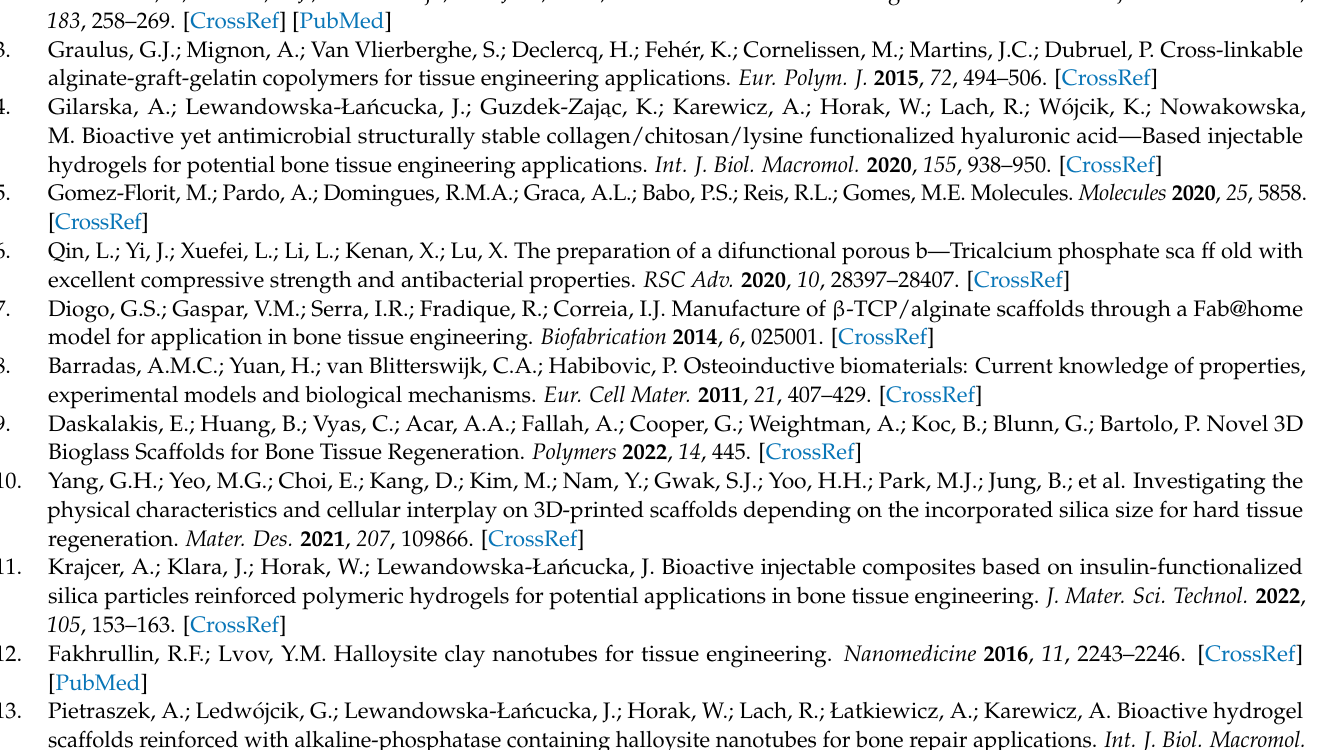
Figure S2: Porosimetry histograms for the hydrogels H1-EDC/CaCl 2 and H2-CaCl 2